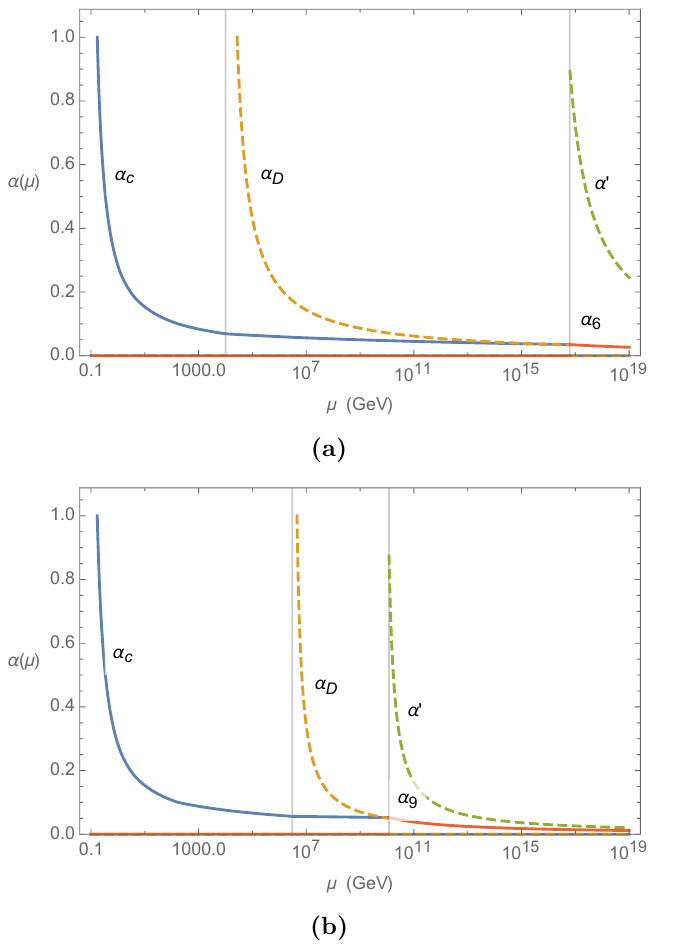
Figure 4. The gauge couplings of the various gauge groups as a function of the renormalization scale. In (a) we assume a hypercolor group Sp (4) HC , N = 3 , Λ HC ’ 6 . 3 × 10 16 GeV and α 0 (Λ HC )